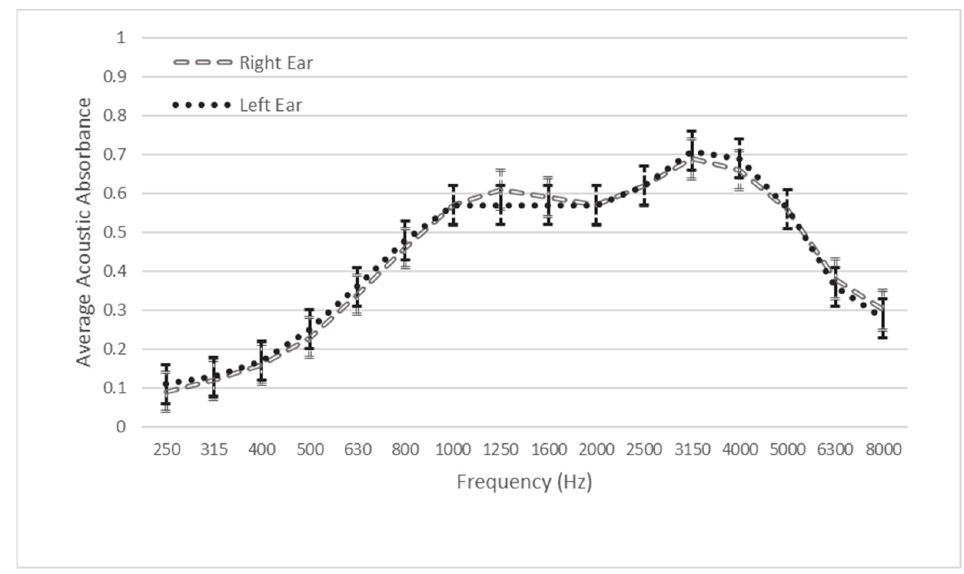
Figure 3. Absorbance per frequency compared between right and left ears in normal-hearing persons, averaged over the pressure settings. No statistically significant difference was associated with laterality. The bars reflect the 95% confidence intervals.